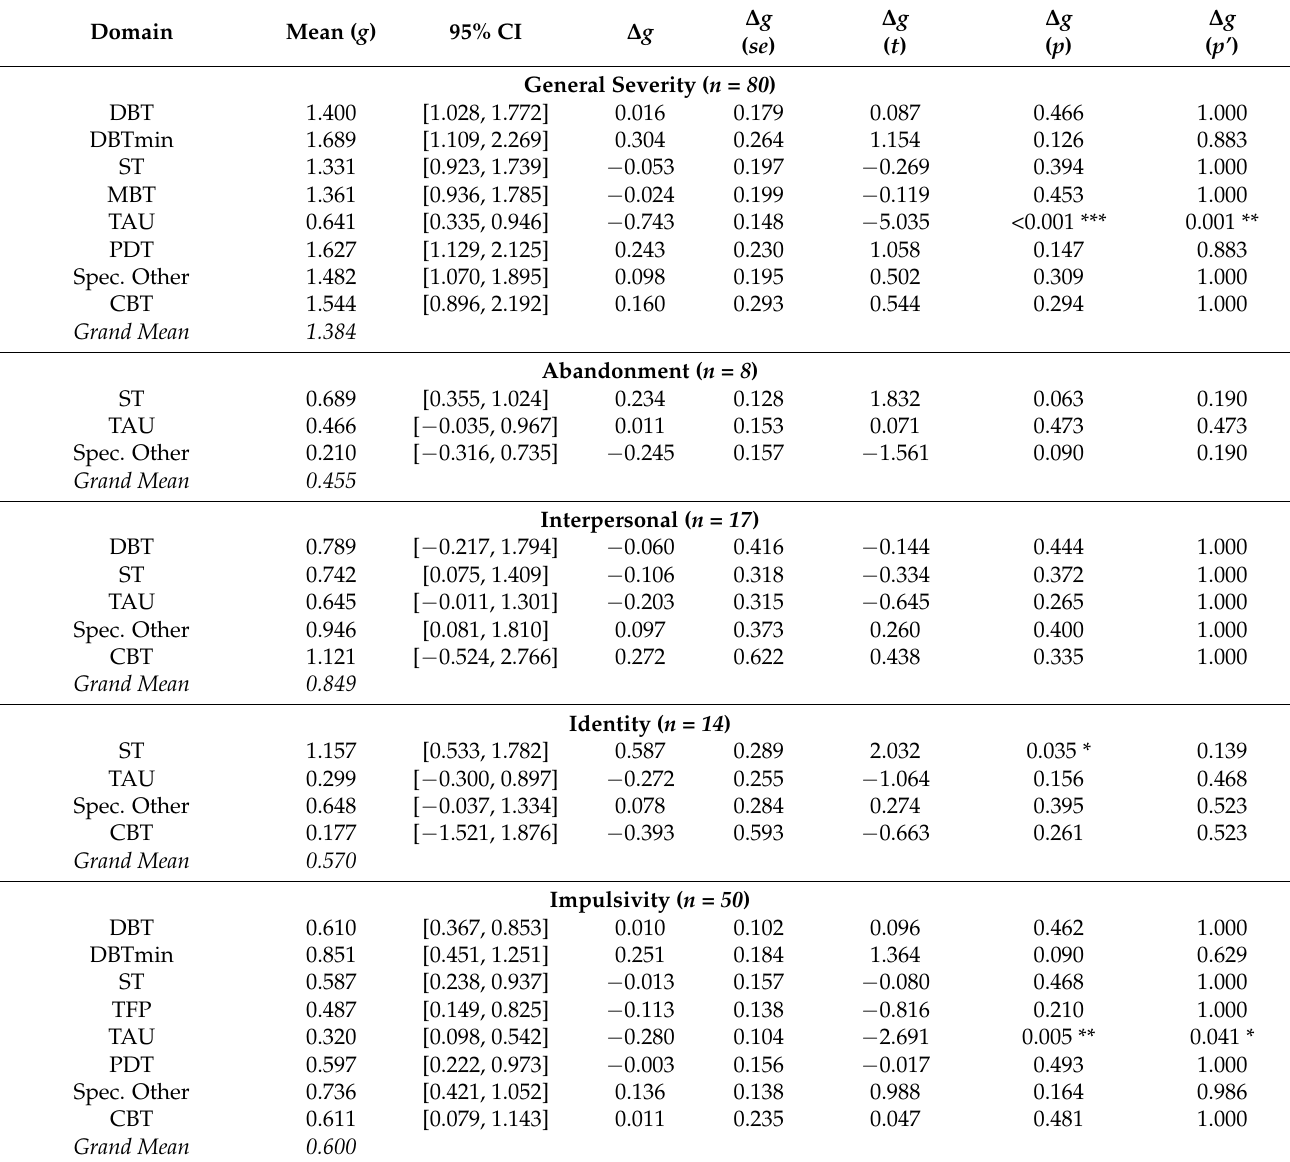
Table 3. Deviation Contrasts of the Interaction between Treatment and BPD Domain at One